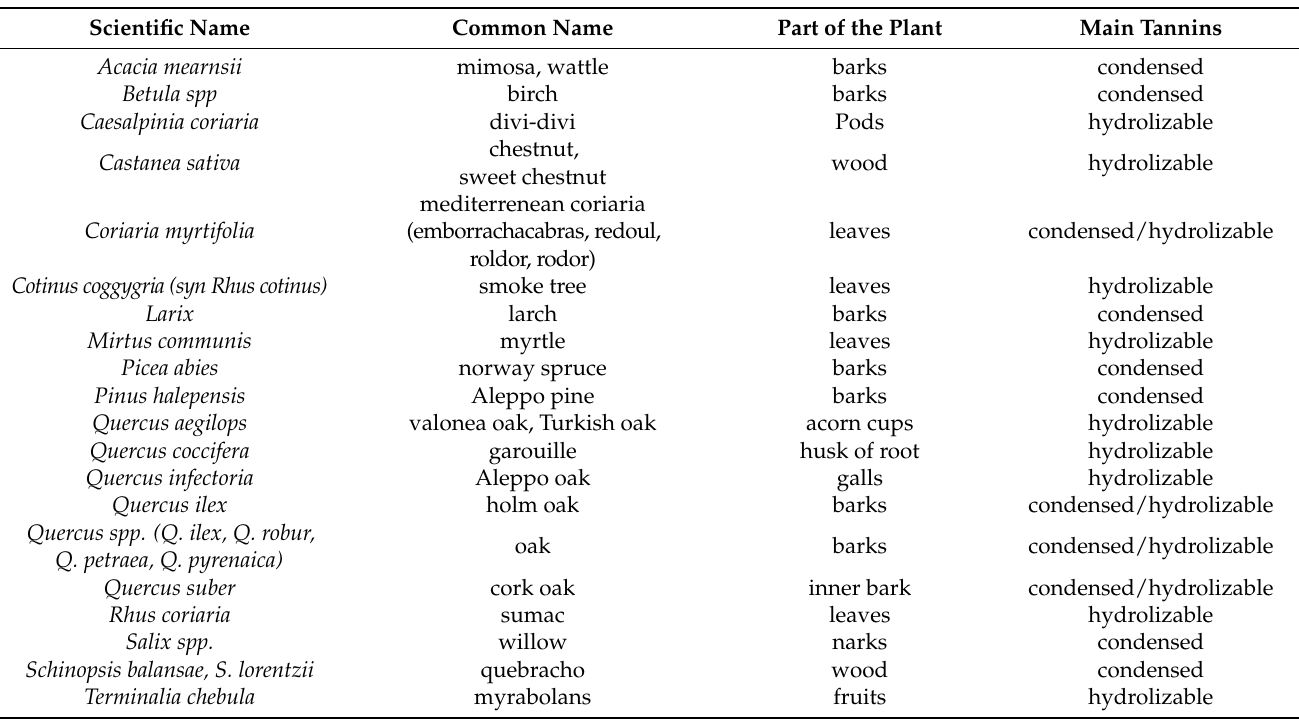
Table 1. Potential tannins’ source for animal feeding reported with their scientific name, common name, part of the plant richest in tannins and tannins’ chemical profile. Traditional and ancient vegetable tannins source used for ruminants [12–15].